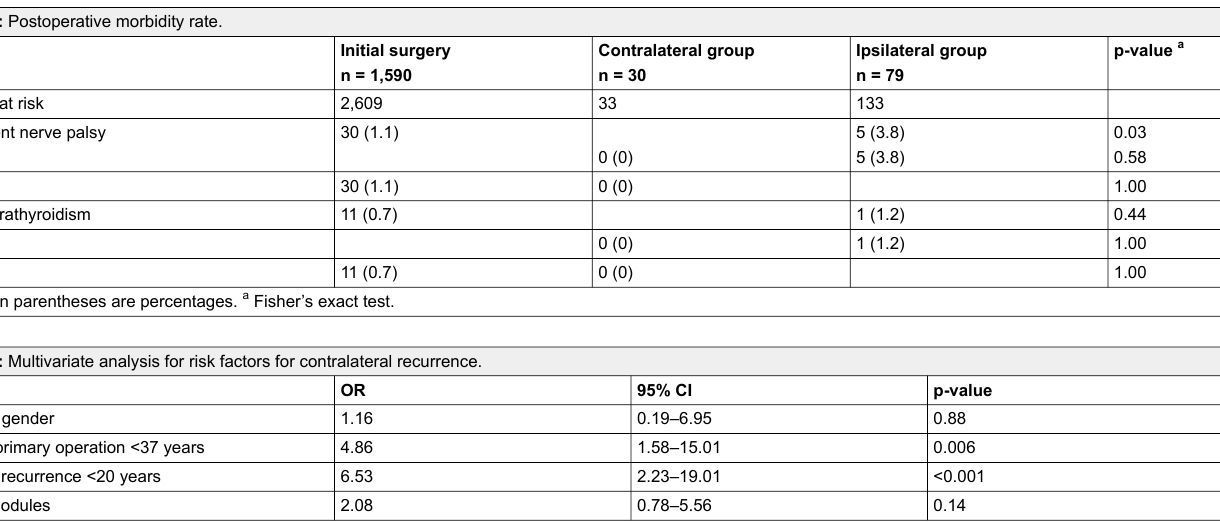
Table 2: Postoperative morbidity rate.